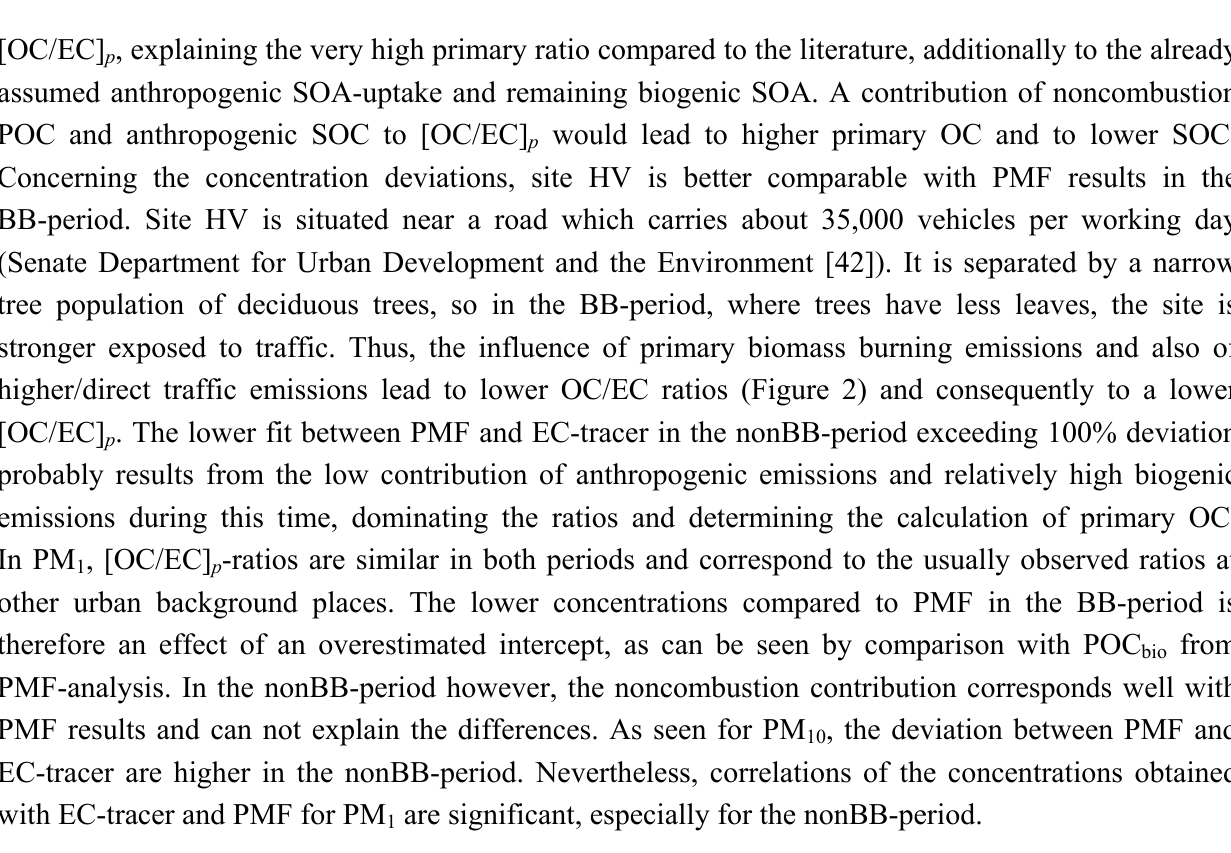
Figure 4. PMF- and EC-tracer-SOC and correlations between SOC derived with both methods (after Pearson). Time series are represented for the BB- and